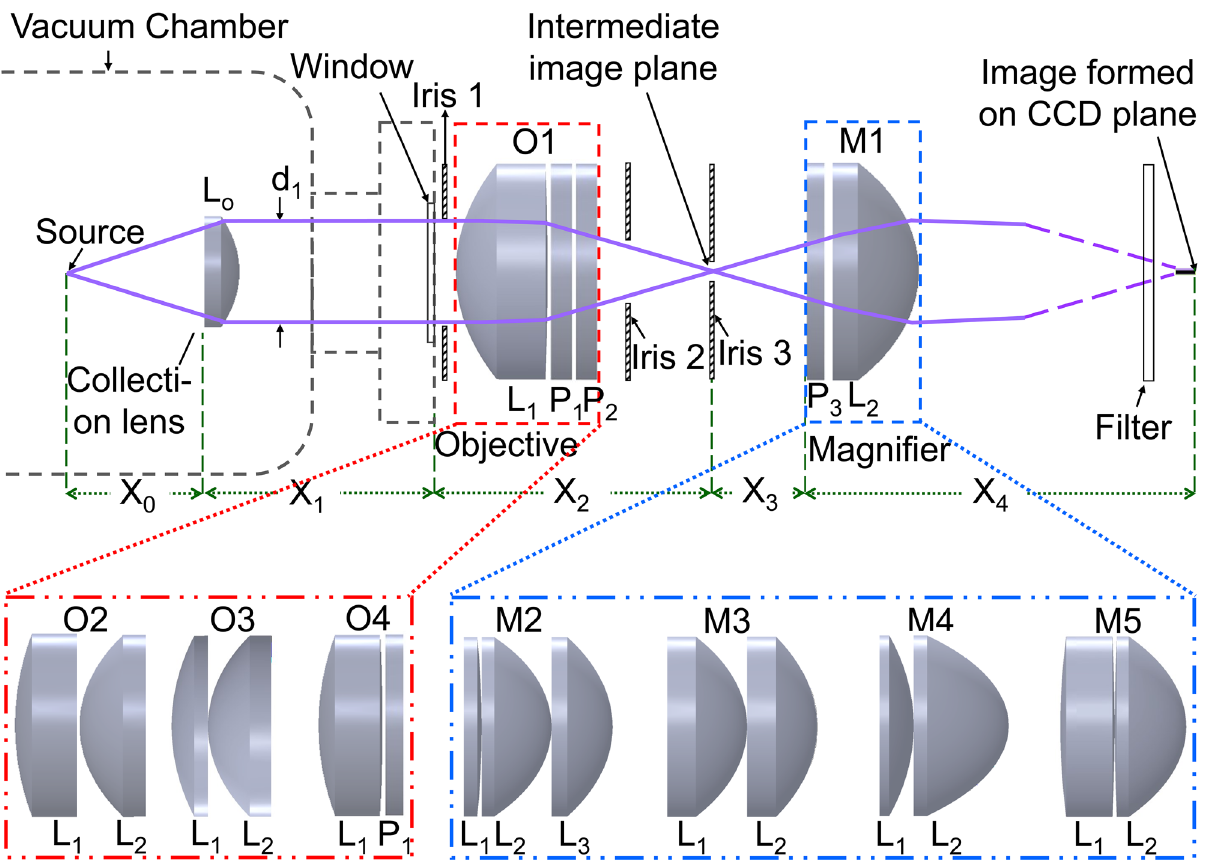
Figure 1. Schematic of the imaging system considering a variety of objectives O1–O4 and magnifiers M1– M5. Lenses and wavefront corrector plates (WCP) are indicated as L i and P i , respectively, where i is their numbers. The collection lens L , and optics in objective, magnifier are of standard 25 mm and 50 mm diameter, ◦ respectively. For the L –O1–M1 combination, indicated length scales are X ◦ mm, X 3 = 34 mm and X 4 = 4154